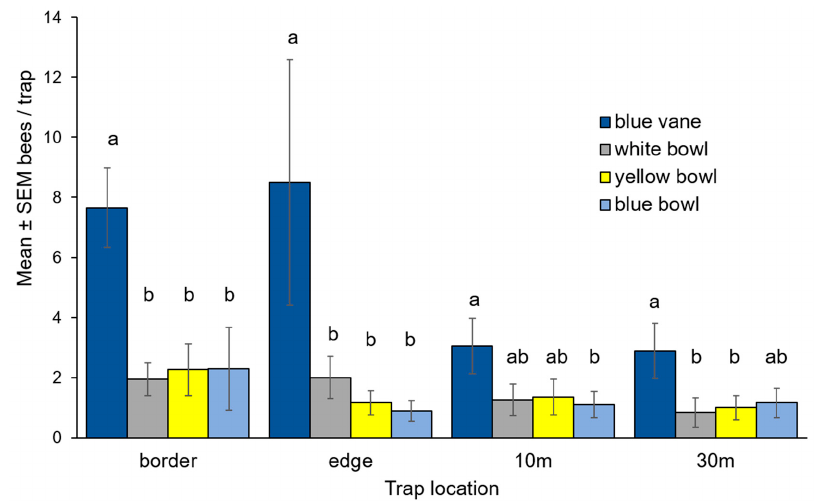
Figure 3. Mean ± SEM number of bees captured in commercial potato fields in Michigan in 2016 by trap type and trap location. Bowl traps were elevated on a platform at canopy height, with one bowl of each color on each platform. A transect of four bowl trap platforms ran from bordering vegetation roughly 10 m from the potato field (“border”), at the edge of the field (“edge”), 10 m into the potato field (“10 m”), and 30 m into the potato field (“30 m”). Blue vane traps were suspended from a metal pole at canopy height, and placed in a parallel transect 10 m from the bowl trap transect. Different letters above bars indicate significantly different ( α = 0.05) abundances in Tukey’s HSD test within locations.